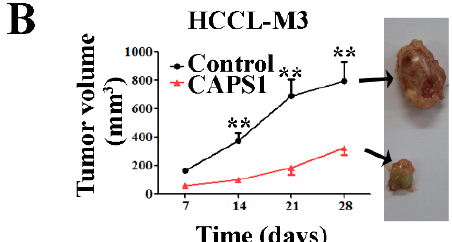
Figure 5. CAPS1 expression decreased tumor formation of hepatoma cells in vivo in nude mice. In vivo subcutaneous tumor growth curves and representative images of harvested subcutaneous tumors of Huh7 cells ( A ) and HCCLM3 cells ( B ) stably transfected with control vector or CAPS1 ( n = 6). ** p < 0.01 vs. CAPS1 group.